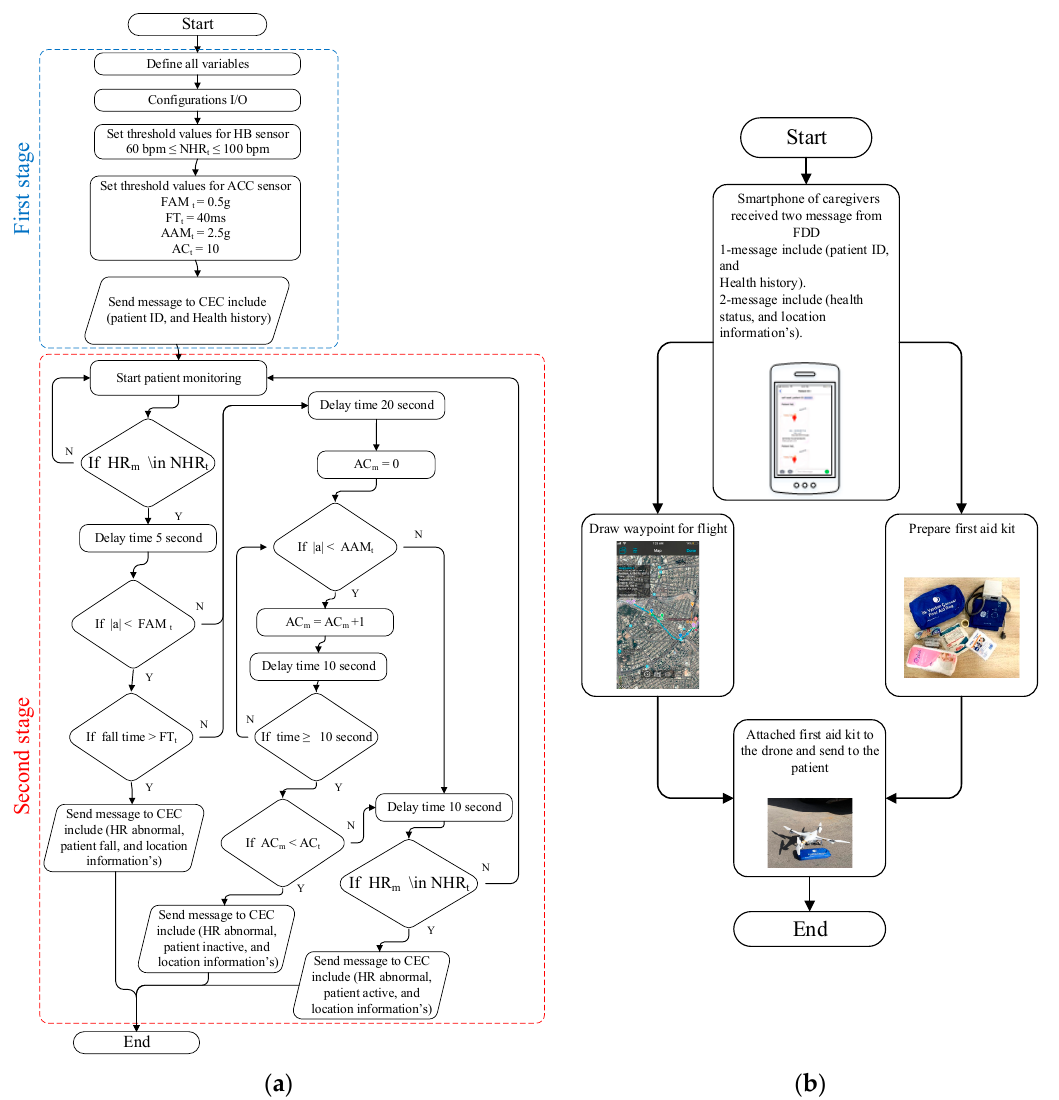
Figure 5. Flowchart algorithms of AFAS for ( a ) FDD and ( b ) CEC.